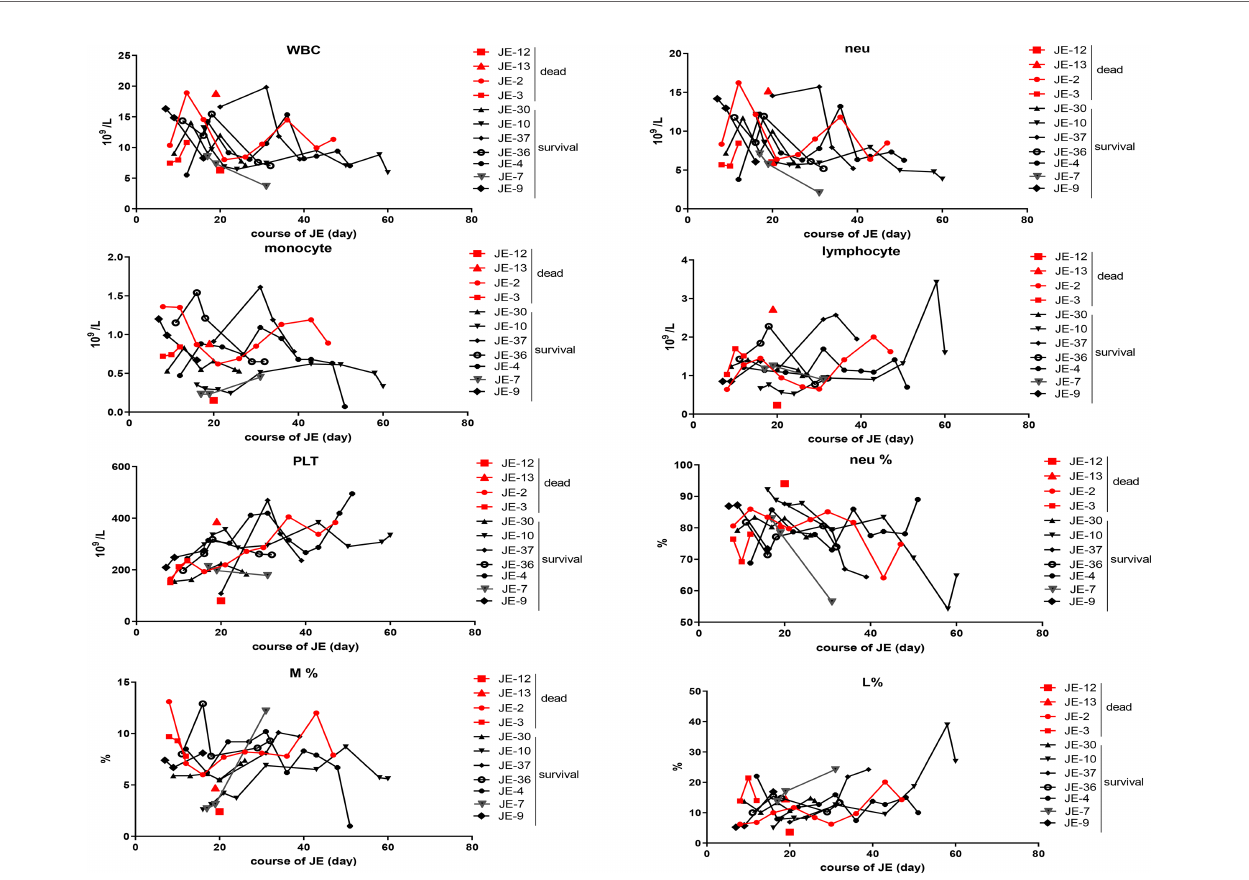
FIGURE 5 | Dynamic changes of the main classi fi cation of immune cells according to the blood routine test in severe survived patients or not. The total numbers of white blood cell (WBC), neutrophil (neu), monocyte, lymphocyte, and blood platelet (PLT) from the fatal and survived individuals were counted respectively according to the blood routine test. The percentage of neutrophil, monocyte, and lymphocyte in each case was described